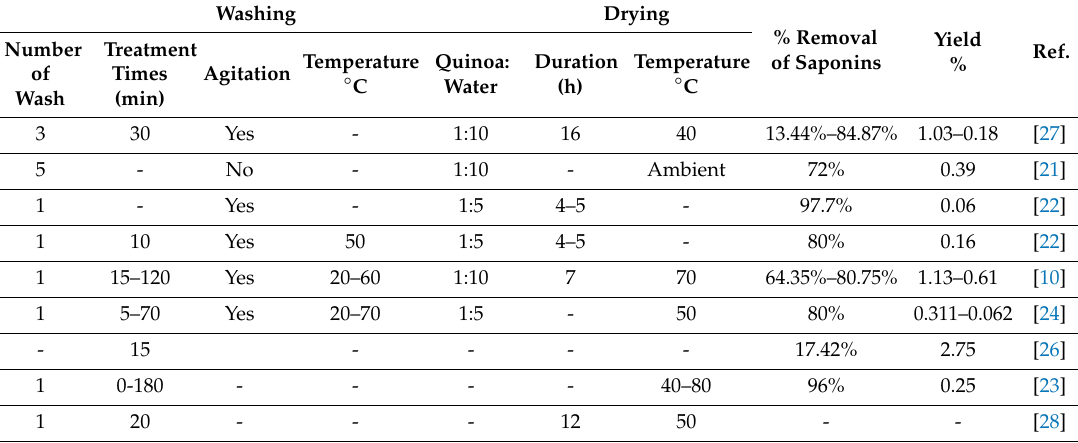
Table 1. Wet washing methods of quinoa